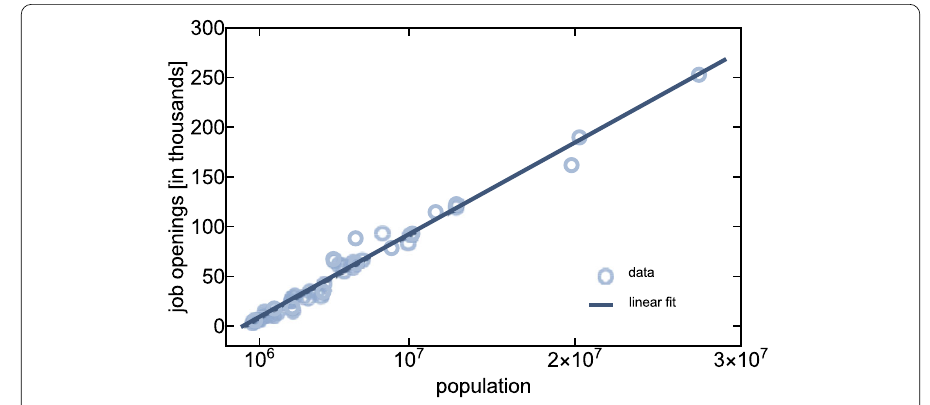
Figure 5 The total number of job openings for different states as a function of the population of the state